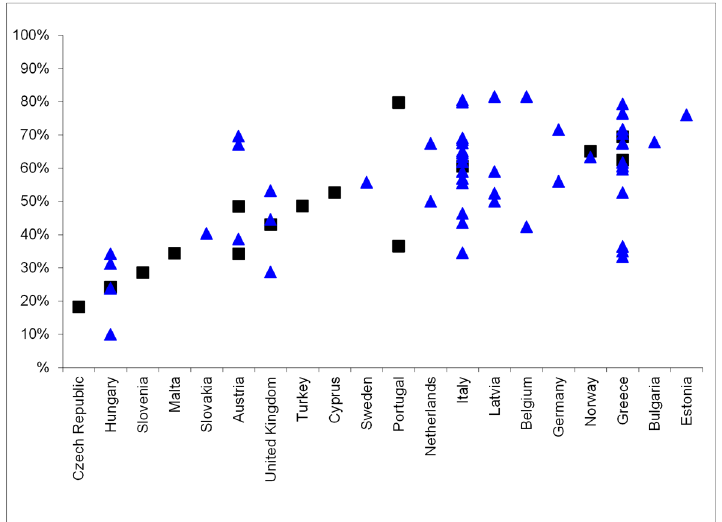
Figure 9. HCV antibody prevalence (%) among PWID in the EU, 2006–2011. Note Figure 9: Source EMCDDA, 2013 (http://www.emcdda. europa.eu/stats13 # inf:displayTables); black squares are data with national coverage, blue triangles are data with sub-national (local, regional) coverage.